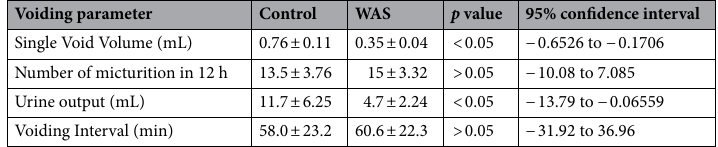
Table 1. Metabolic cage urination parameters. All values are expressed as mean ±